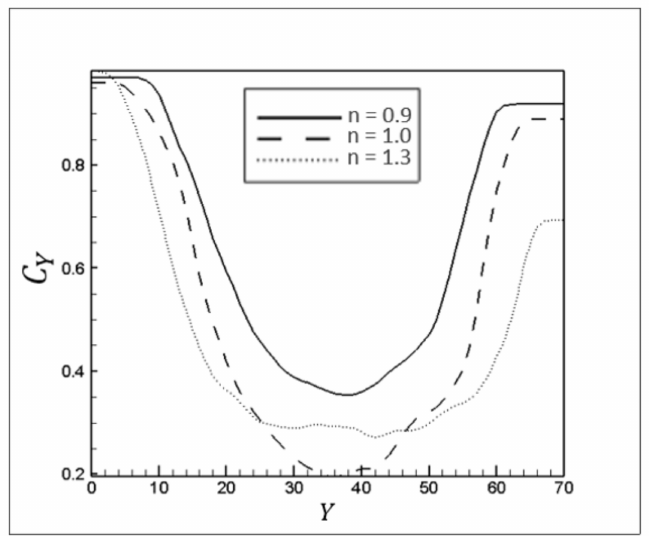
Figure 21. Longitudinal displacement efficiency over the channel height for different